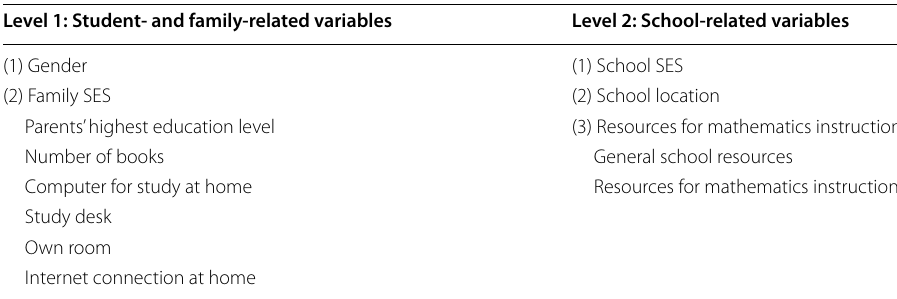
Table 2 List of explanatory variables in the study Level 1: Student- and family-related